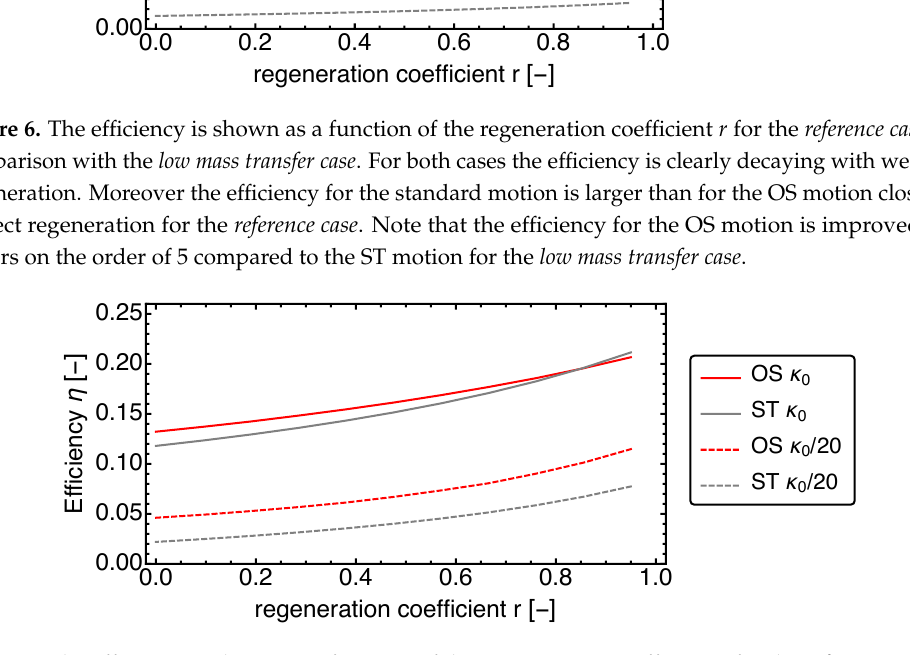
Figure 7. The efficiency is shown as a function of the regeneration coefficient r for the reference case in comparison with the low conductance case . For both cases the efficiency is clearly decaying with weaker regeneration. Again the efficiency for the standard motion is larger than for the OS motion close to perfect regeneration for the reference case